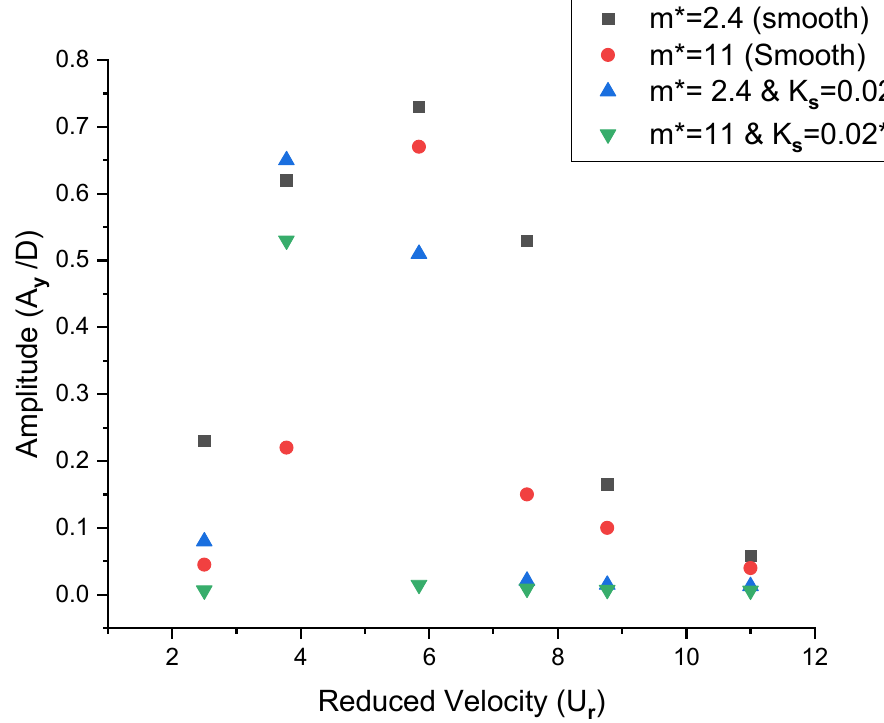
Figure 5. Comparison of amplitude responses for a smooth cylinder and a rough cylinder (i.e., Ks/D = 2 × 10 − 2 ) with m* = 2.4 and 11.